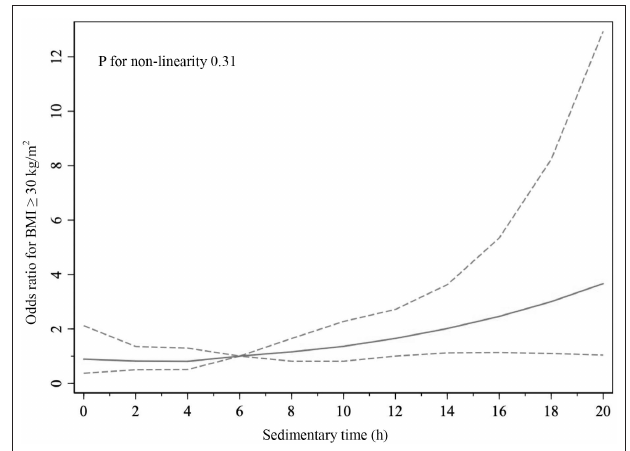
FIGURE 2 | Association of sedimentary time with BMI ≥ 30 kg/m 2 in CHF